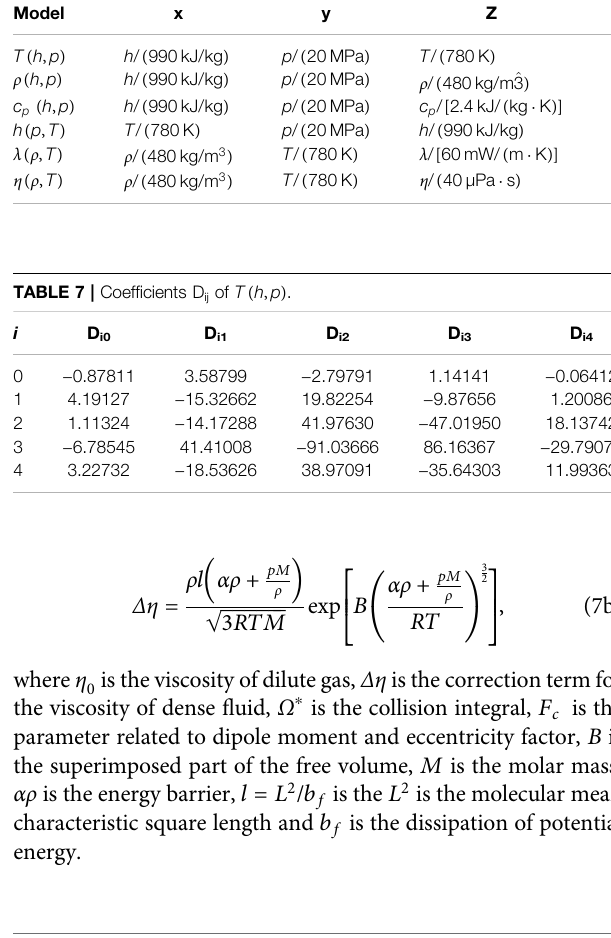
TABLE 6 | Speci fi c physical properties represented by x, y, z and the n value of each model. Model